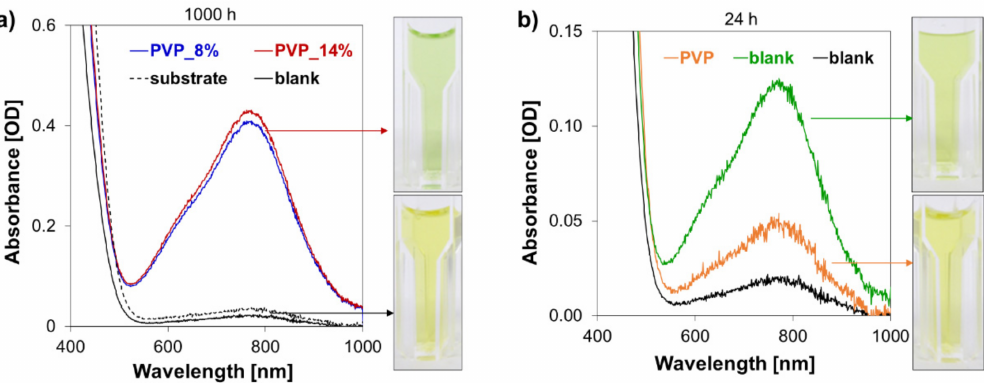
Figure 8. ( a ) UV-Vis spectra of the ageing solutions for the fabricated membranes after 1000 h of test, the substrate material is reported as reference. Oxidative degradation is observed for the PVP based hierarchical membranes. ( b ) UV-Vis spectra of the ageing solutions for the coating components after 24 h of test: the crosslinked matrix shows noticeably faster oxidation than